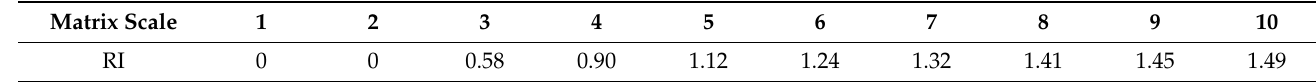
Table 4. The value set of